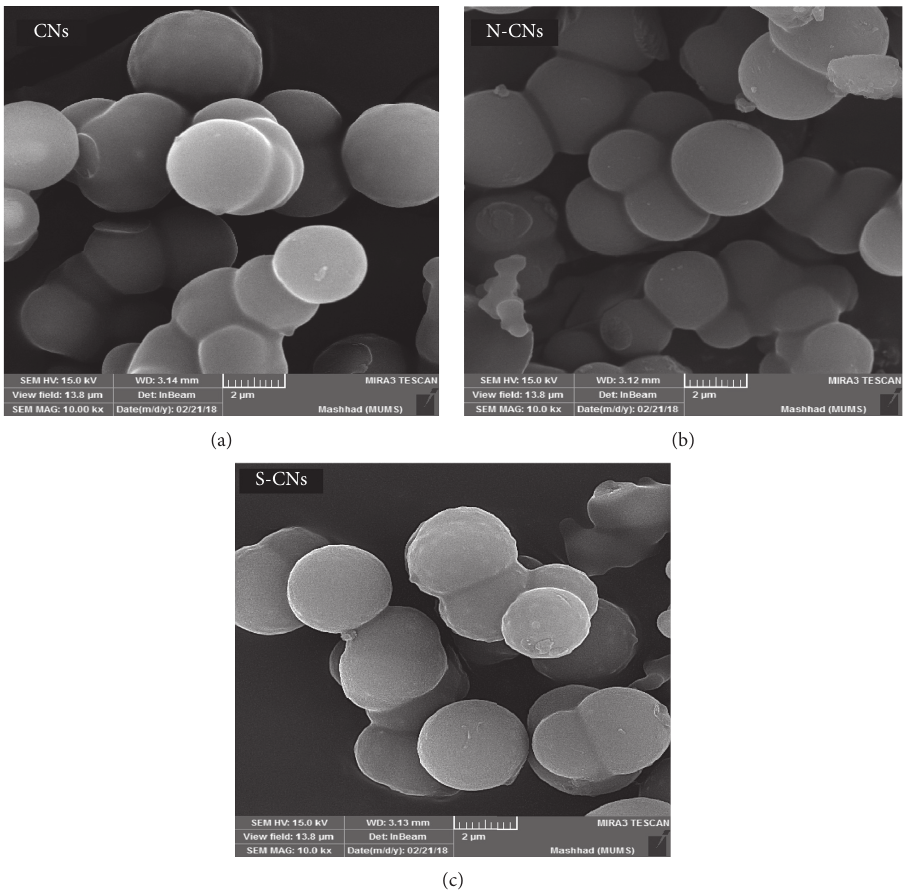
Figure 3: FE-SEM images of (a) CNs, (b) N-CNs, and (c) S-CNs.